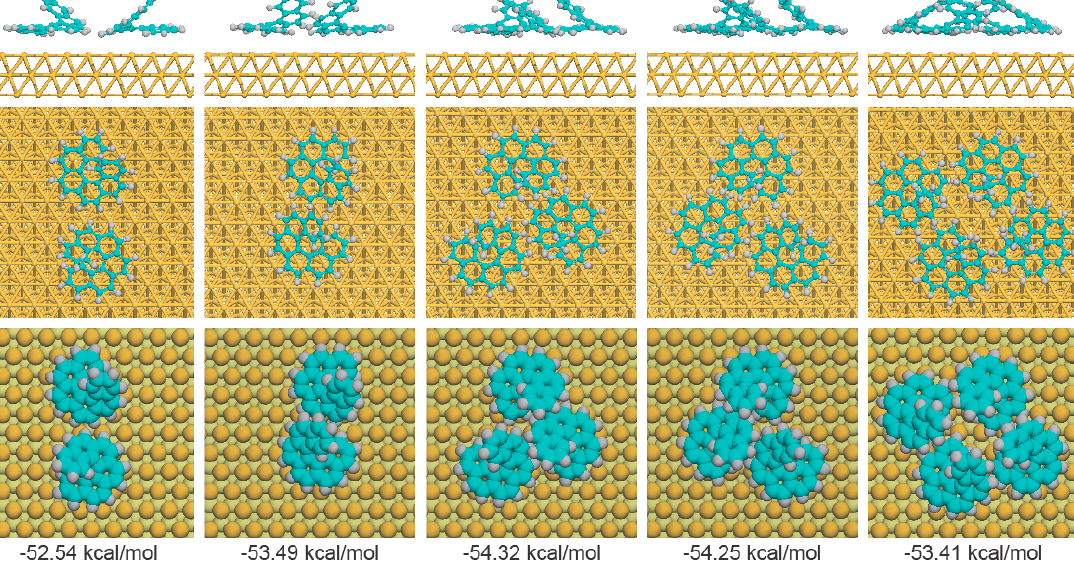
Figure 5. The side, top view (ball-stick model) and top view (space-filling model) of binding configurations of ( a ) homochiral dimer, ( b ) heterochiral dimer, ( c ) heterochiral trimer A, ( d ) trimer B and ( e ) homochiral tetramer, with corresponding binding energy for each [6]H labeled below.